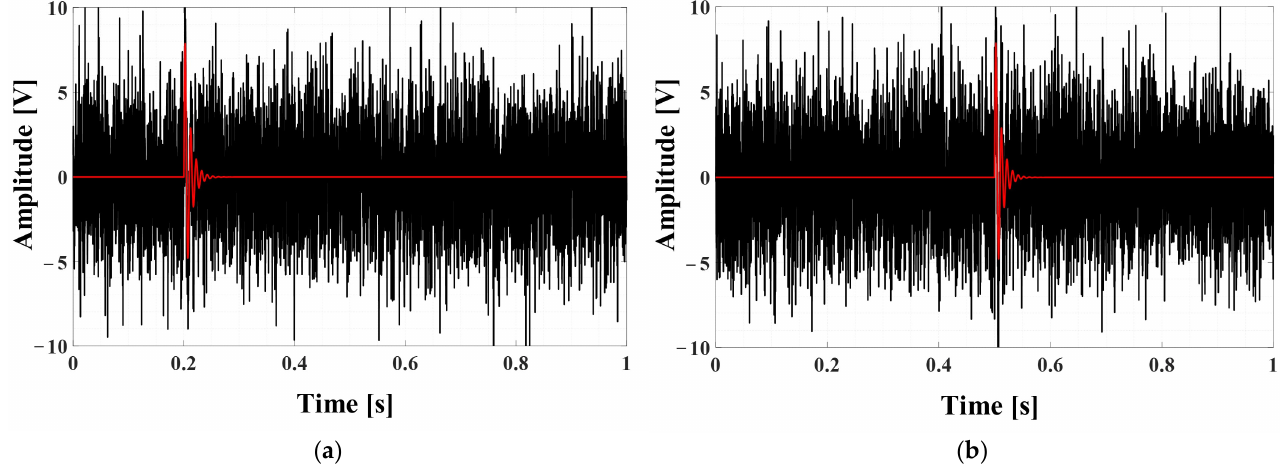
Figure 4. Virtual measurement signal: ( a ) virtual measurement signal x(t) and ( b ) virtual measure- ment signal y(t).